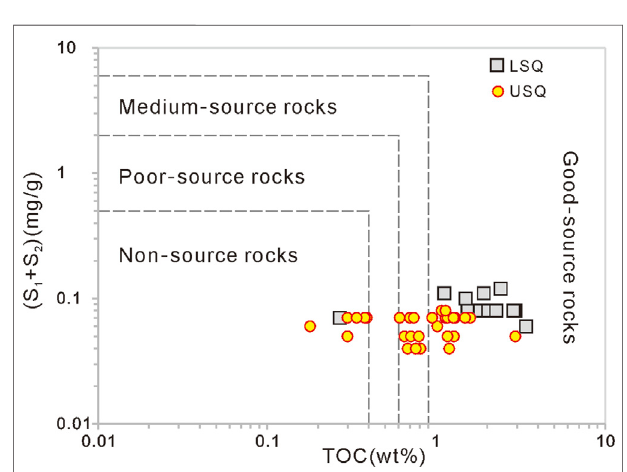
FIGURE 4 | Characteristic map of total organic carbon (TOC) vs. S 1 +S 2 from the Qiongzhusi Fm, W-207 Well. LSQ: lower section of Qiongzhusi Fm (3,242.42 – 3,177.64 m); USQ: upper section of Qiongzhusi Fm (3,161.69 – 3,000.59 m).